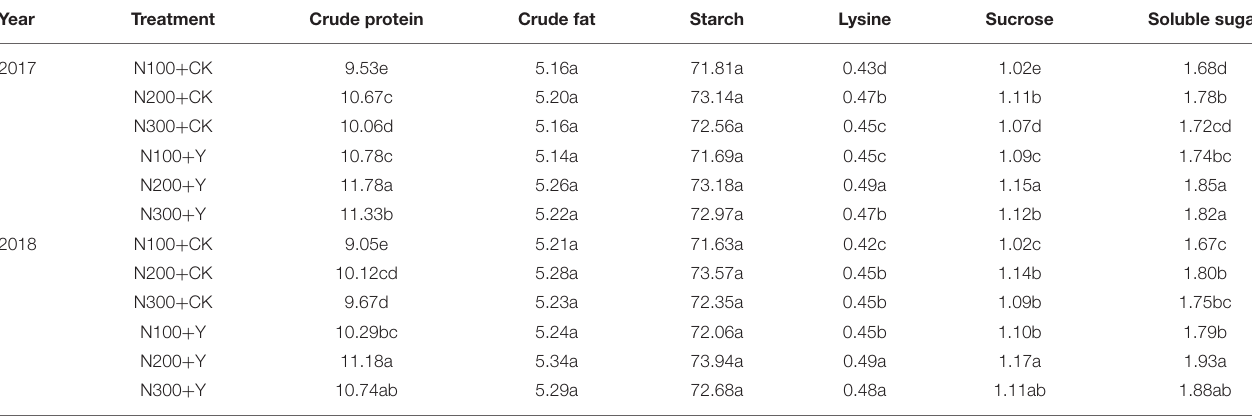
TABLE 7 | Effects of chemical control and nitrogen fertilizers on grain nutrients concentrations (%) of maize during maize growing period 2017 and 2018. Year